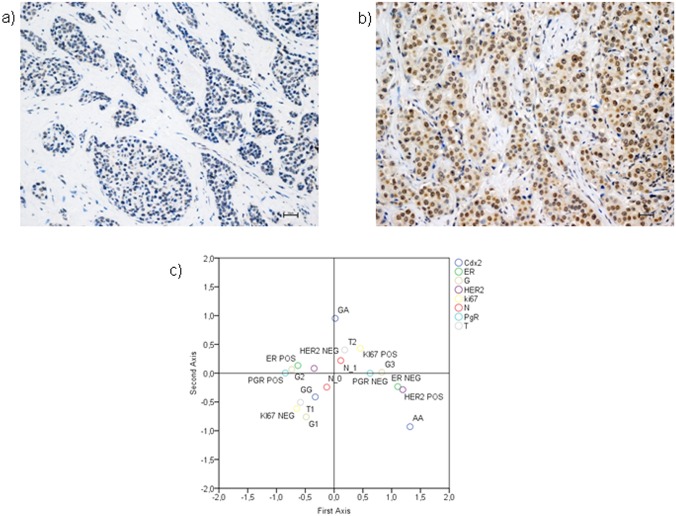
Immunohistochemical analyses.Representative immunohistochemical figures of ductal infiltrating breast cancer with low VDR expression (score 3) (a) and with high VDR expression (score 8) (b). Scale bar 30 μ. (c) The MCA graph demonstrated that phenotype AA is located in the quadrant containing the most aggressive parameters (T3 tumours, HER2 positive, ER negative and G3 in contrast to phenotype GG which is associated to more favorable bio-pathological parameters [T1 tumours, N0, G1, ki67 (-)].